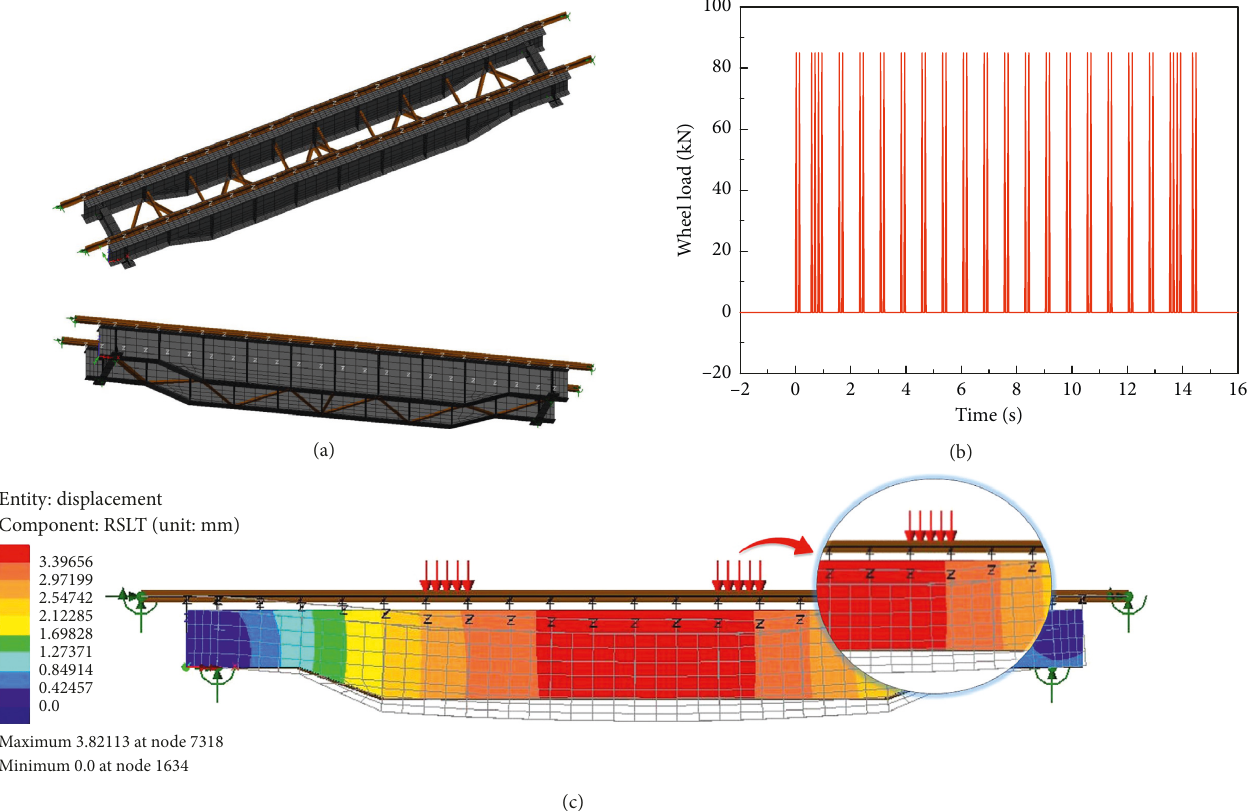
Figure 2: Finite element analysis. (a) 3D view of the FE model. (b) Example of the time-history function (KTX, 90km/h). (c) Analysis results for the displacement of the rail and track